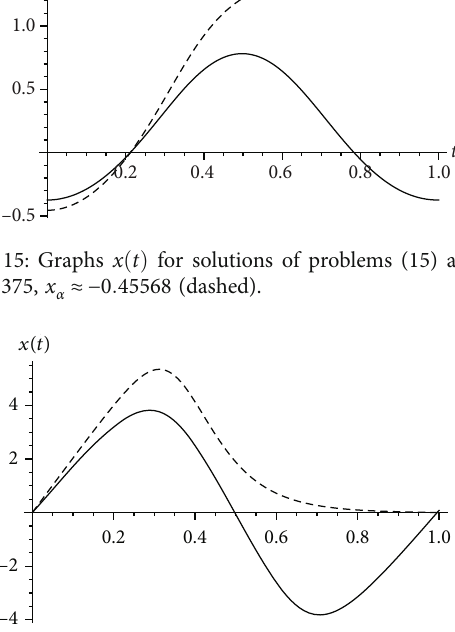
Figure 16: Graphs x ′ ð t Þ for solutions of problems (15) and (30), x α ≈ − 0 : 375 , x α ≈ − 0 : 45568 (dashed).